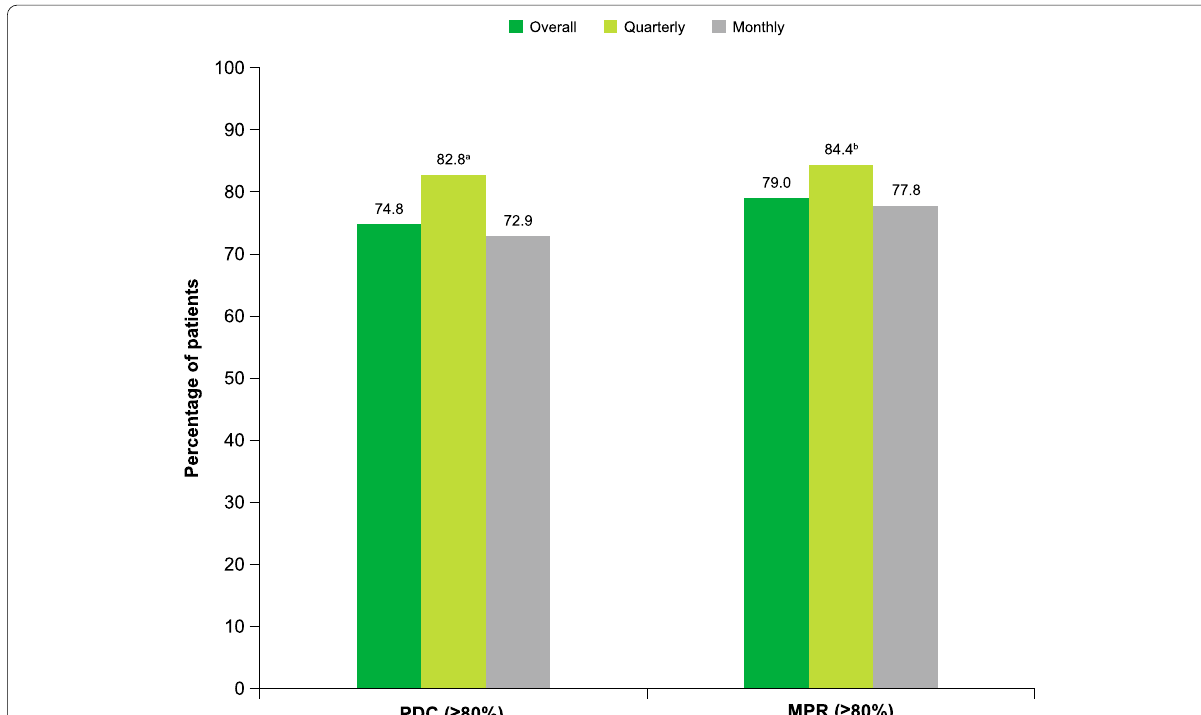
Fig. 2 Adherence to fremanezumab therapy. PDC proportion of days covered; MPR medication possession ratio. P values calculated between